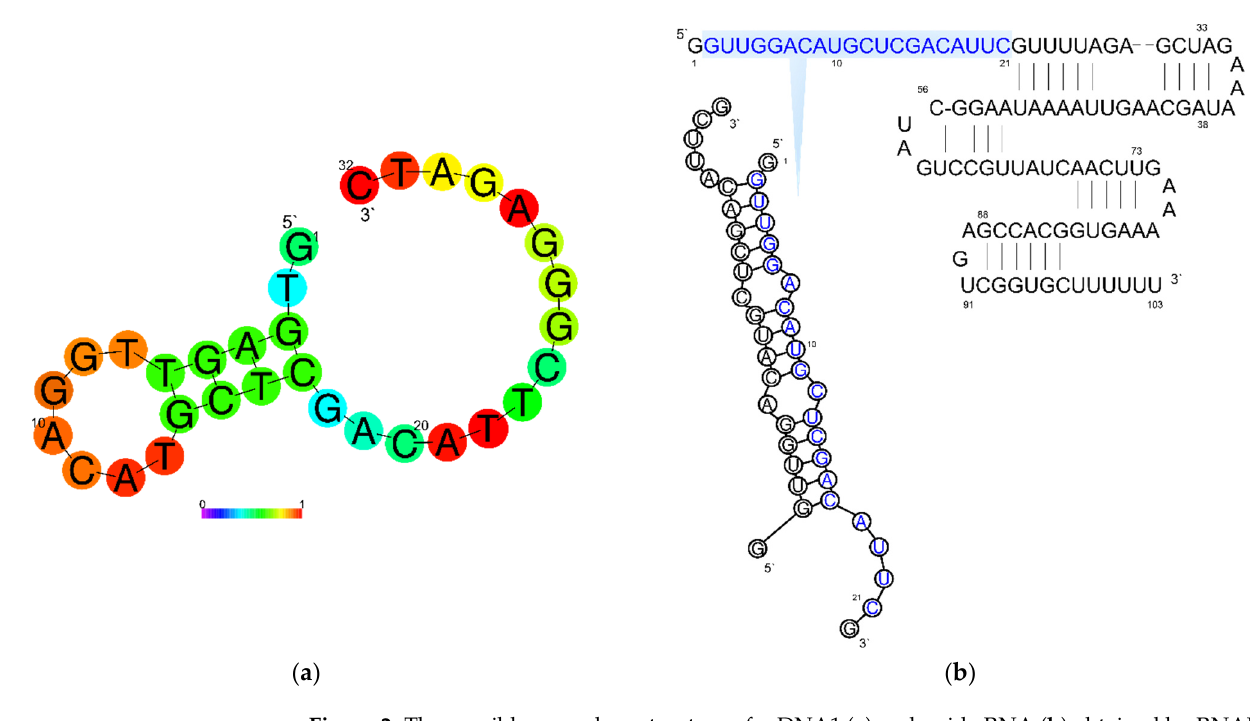
Table 1. The thermodynamic parameters obtained by ITC.